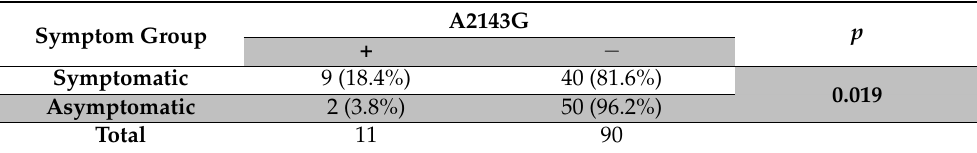
Table 4. The distribution of the A2143G mutation by symptom group.